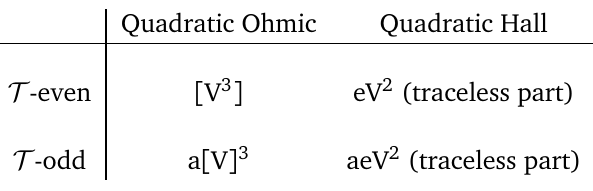
Table 1: Decomposition of the quadratic conductivity into Ohmic vs Hall parts and T -even vs T -odd parts. The Ohmic part is represented by a totally symmetric rank-3 polar tensor [ Eq. (14) ] , and the Hall part by a traceless rank-2 axial tensor [ Eq. (44) ] . Each entry in the table denotes the corresponding Jahn symbol [ 33 ]